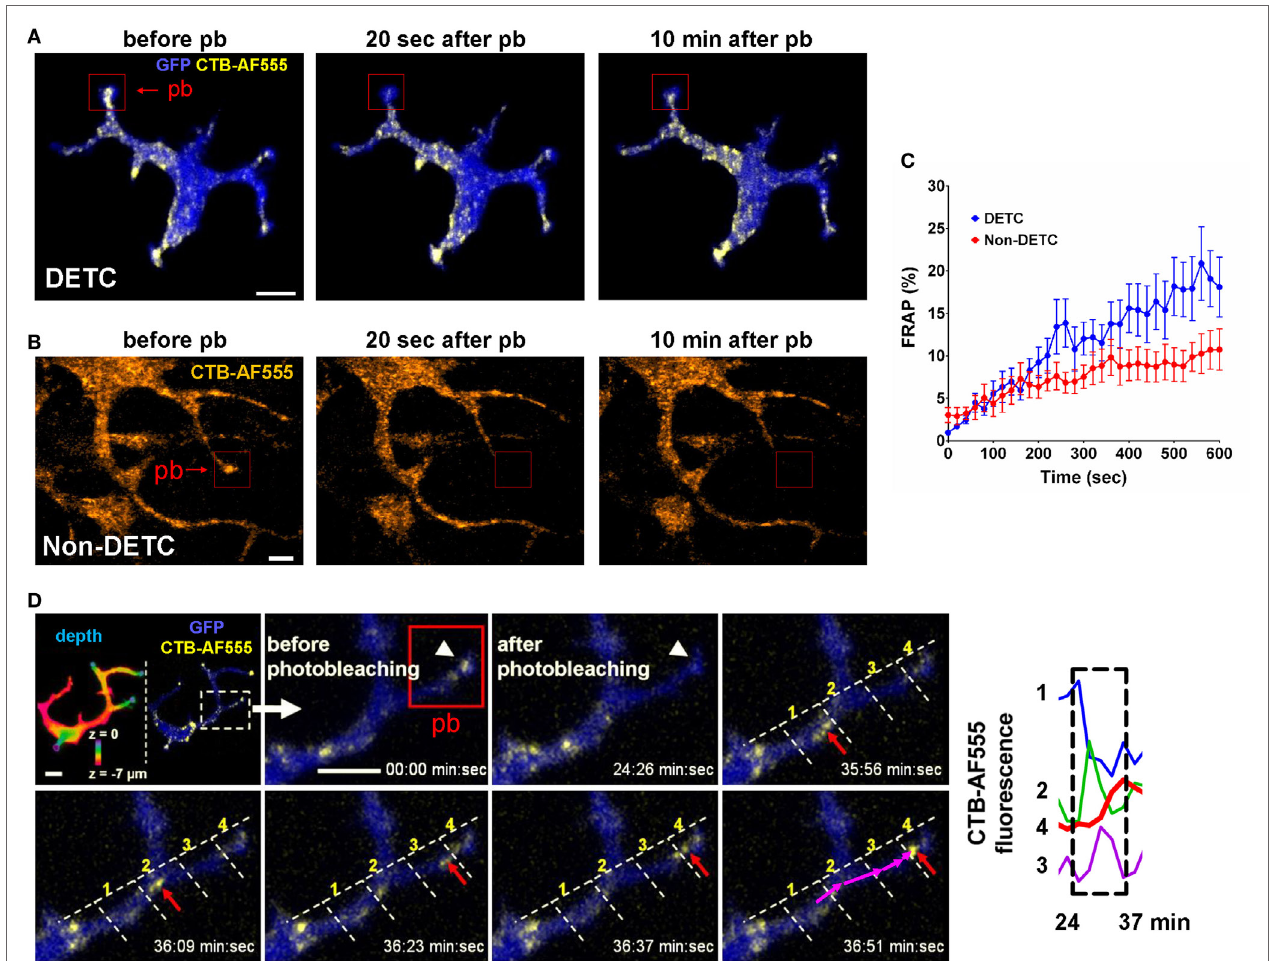
FigUre 4 | In vivo dynamics of dendritic epidermal T cell (DETC) granules labeled with CTB-AF555 in IL2p8-GFP mouse ear. (a) Fluorescence recovery after photobleaching (FRAP) in a DETC dendrite end. The red rectangle area was photobleached (pb) and the cell was imaged for 10 min (see Movie S3 in Supplementary Material). (B) FRAP in a dermal non-DETC dendrite end. The red rectangle area was photobleached and the cell was imaged for 10 min (see Movie S4 in Supplementary Material). (c) Cumulative analysis of FRAP kinetics for multiple dendrite ends ( n = 15 cells in five mice). Each point is a mean ± SEM. (D) Example of cargo movement along dendrite length. Upper left: color-coded depth—the apical localizations are blue-green and basal localizations are red. The dashed rectangle indicates zoom area. AF555 was photobleached in the red rectangle area. AF555 signal was measured in the four regions of interest (ROI) along the dendrite. The red arrow points to granule movement. The graph shows a rapid transition of AF555 (granule) intensity through the four ROIs, this movement starting after 24 min. Scale bars = 5